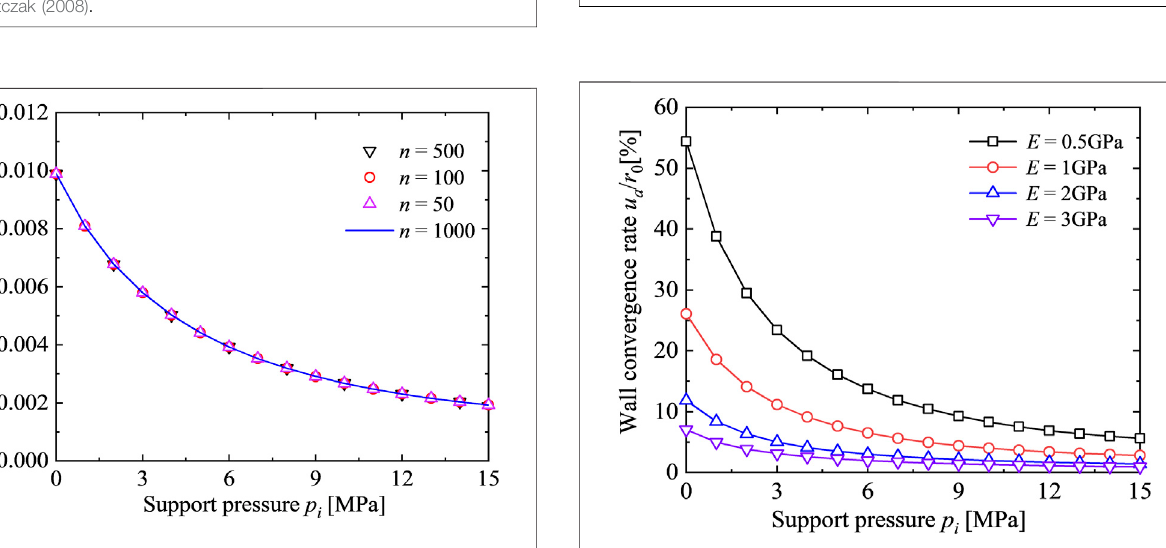
FIGURE 8 | In fl uence of the dilatancy angle.